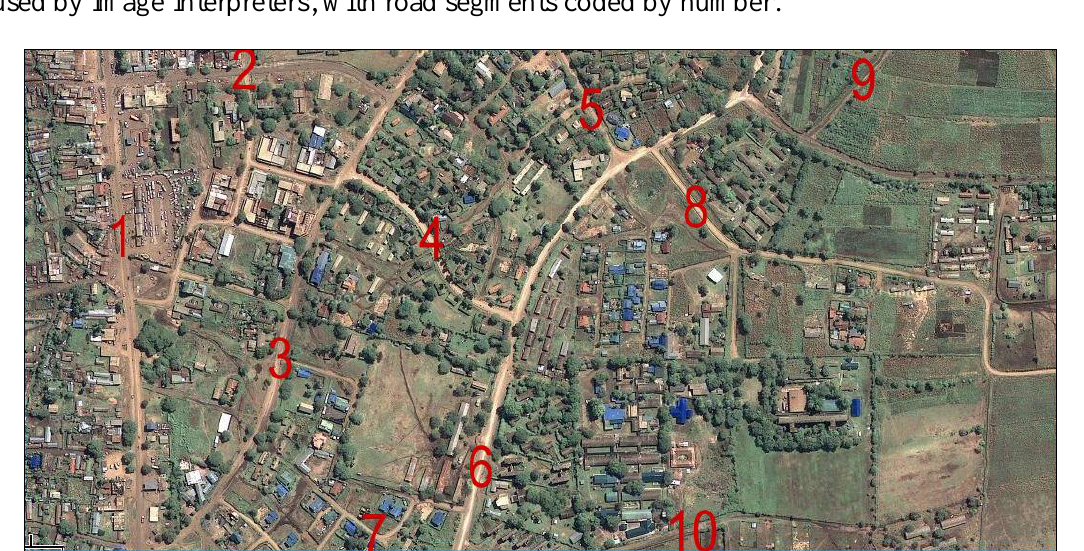
Figure 1. Part of the GeoEye Digital Globe high resolution satellite image of 20 July 2009 used by image interpreters, with road segments coded by number.